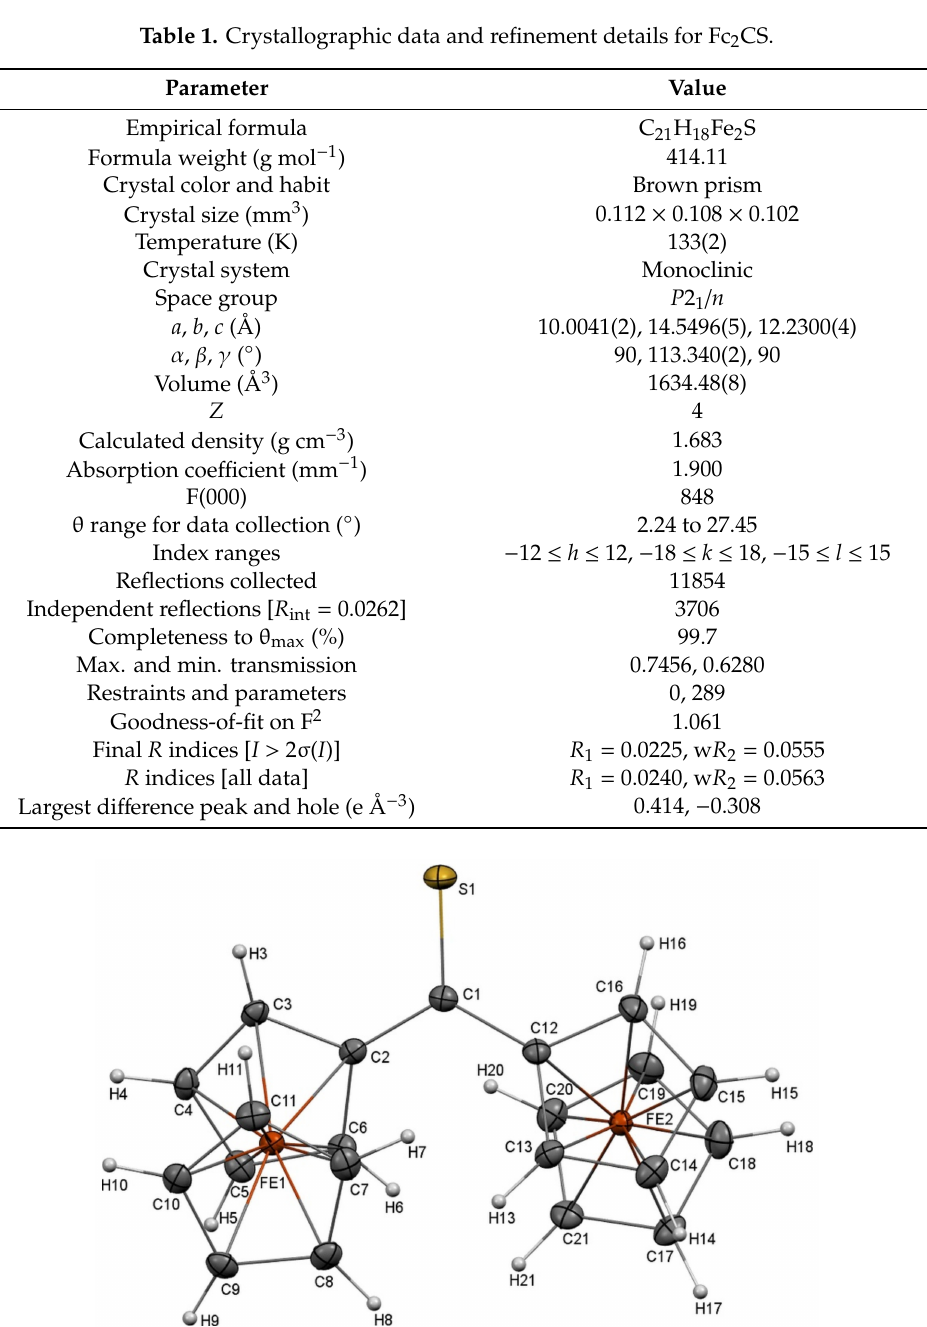
Figure 1. Molecular structure of Fc 2 CS. Displacement ellipsoids are drawn at the 50% probability